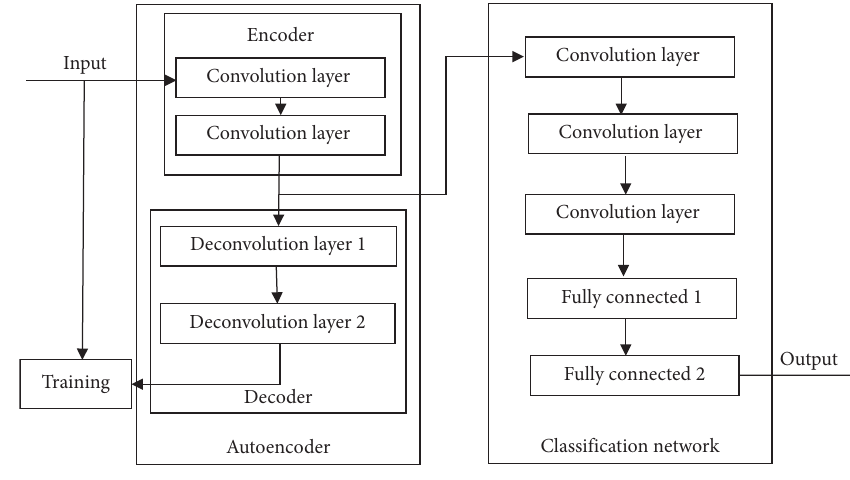
Figure 5: Overall network structure.